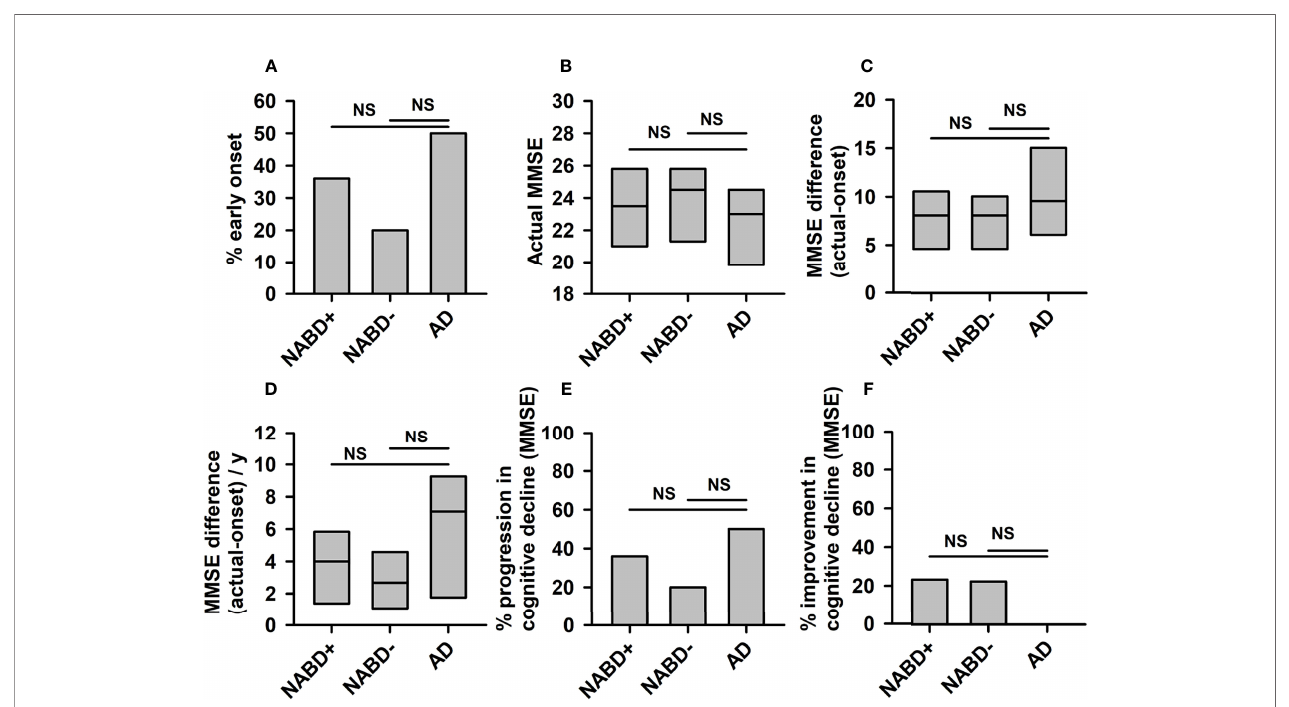
FIGURE 1 | Progression of cognitive dysfunction in neural autoantibody-associated dementia and Alzheimer ’ s dementia. No signi fi cant differences between NABD+ or NABD − and AD were detected regarding the percentual proportion of patients with an early-onset (A) , current MMSE (B) , MMSE difference between onset and current stage without (C) and with division per years of disease duration (D) , the percentual proportion of patients with rapid progression per year (E) , and the percentual proportion of patients with an improvement over time (F) . AD, Alzheimer ’ s dementia; CSF, cerebrospinal fl uid; MMSE, Mini-Mental State Examination; NABD+, neural autoantibody-associated dementia including patients with CSF-based Alzheimer ’ s disease pathology; NABD − , anti-neural autoantibody associated dementia without cerebrospinal fl uid-based Alzheimer ’ s disease pathology; NS, non-signi fi